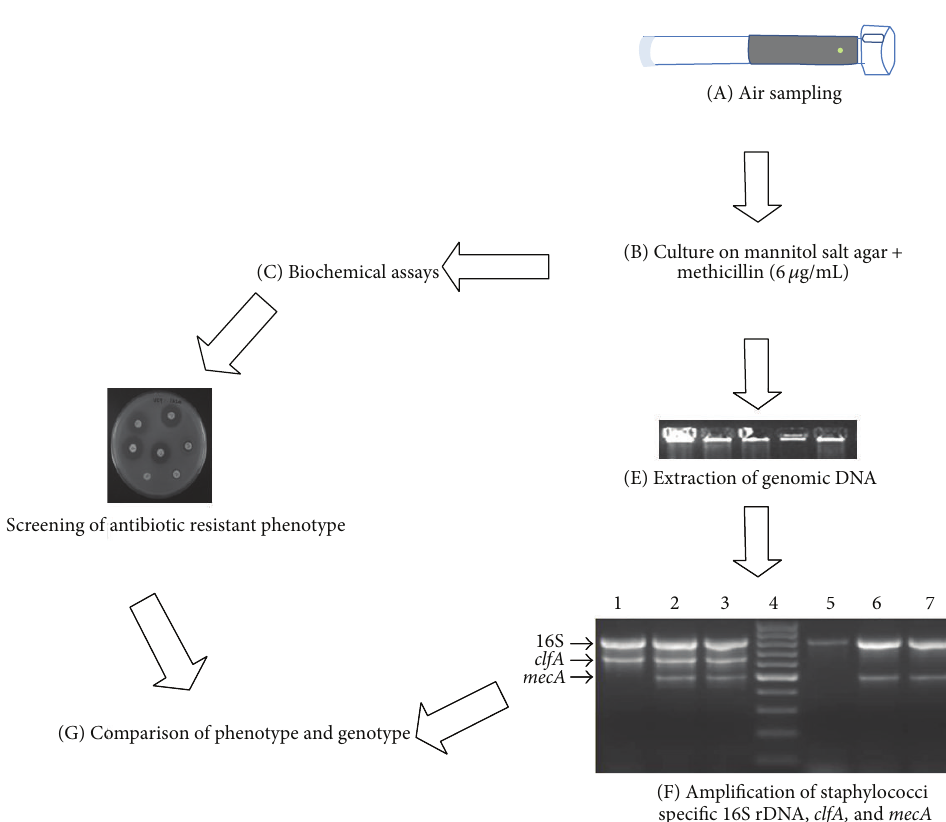
Figure 1: Flow diagram for isolation of MRS bioaerosols from residential houses. (F) Multiplex PCR for the detection of mecA gene in staphylococci. Lane 1: S. aureus ATCC 25923, lane 2: MRS isolate AMR 911, lane 3: MRS isolate AMR 927, lane 4: 100bp ladder, lane 5: S. epidermidis ATCC 12228, lane 6: MRS isolate AMR 901, and lane 7: MRS isolate AMR 904.